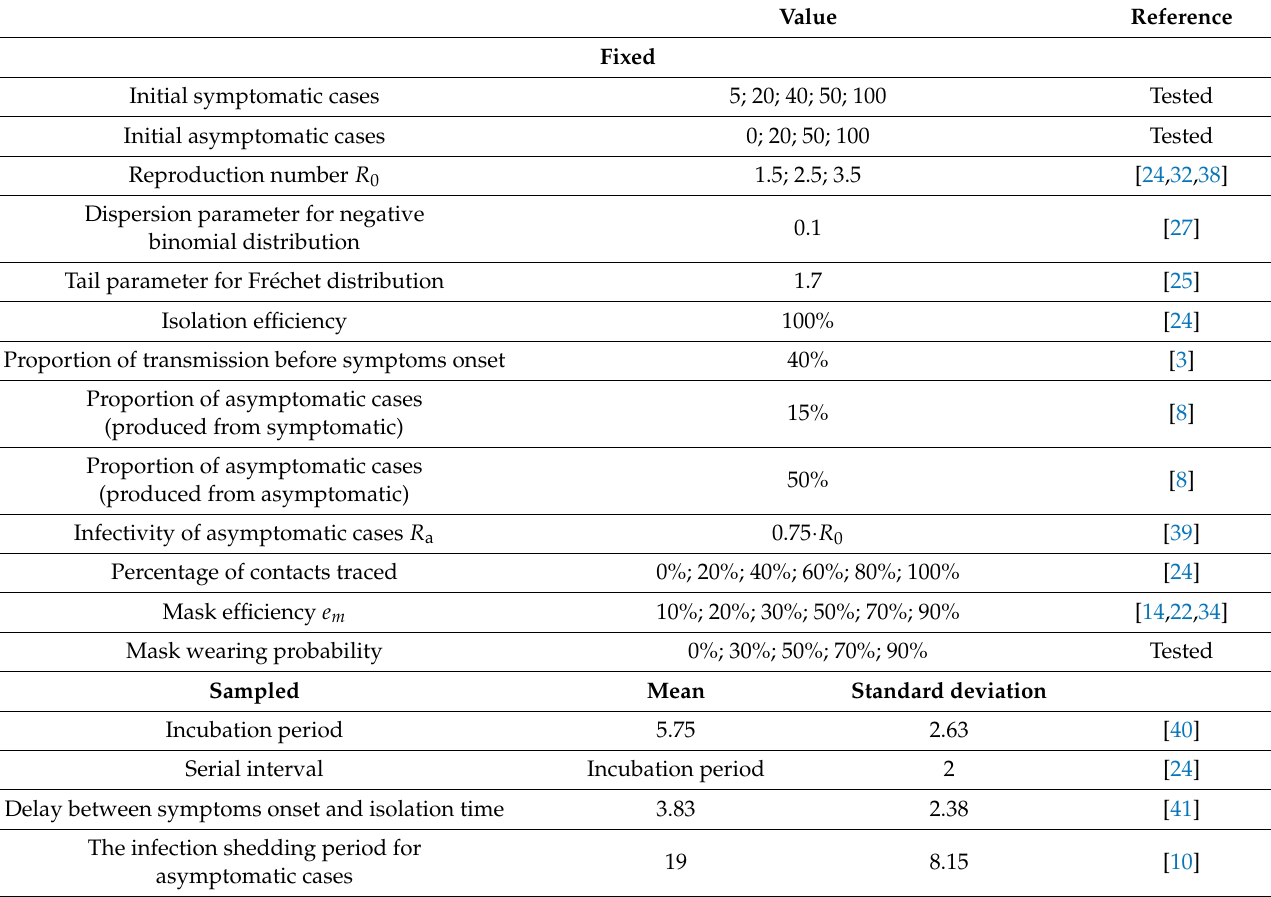
Table 1. Parameter values used in the